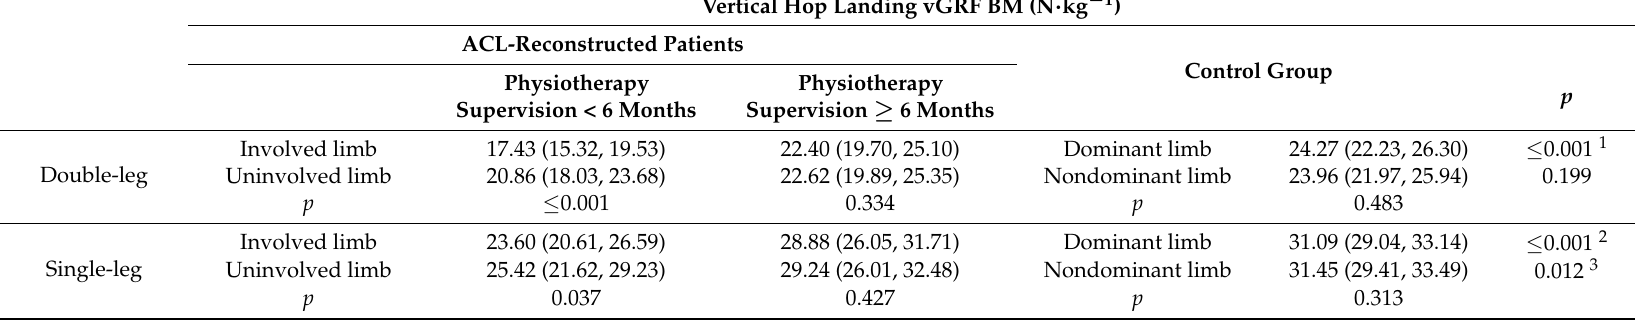
Table 3. Between-limb and between-group comparison of the vertical ground reaction force values obtained during the double-leg and single-leg vertical hop landing in the patients with postoperative physiotherapy supervision <6 months, patients with postoperative physiotherapy supervision ≥ 6 months, and control group; ACL: anterior cruciate ligament; p : level of significance of the between-limb and between-group difference; vGRF BM: vertical ground reaction force normalized to body mass. Values expressed as the arithmetic mean and 95% confidence